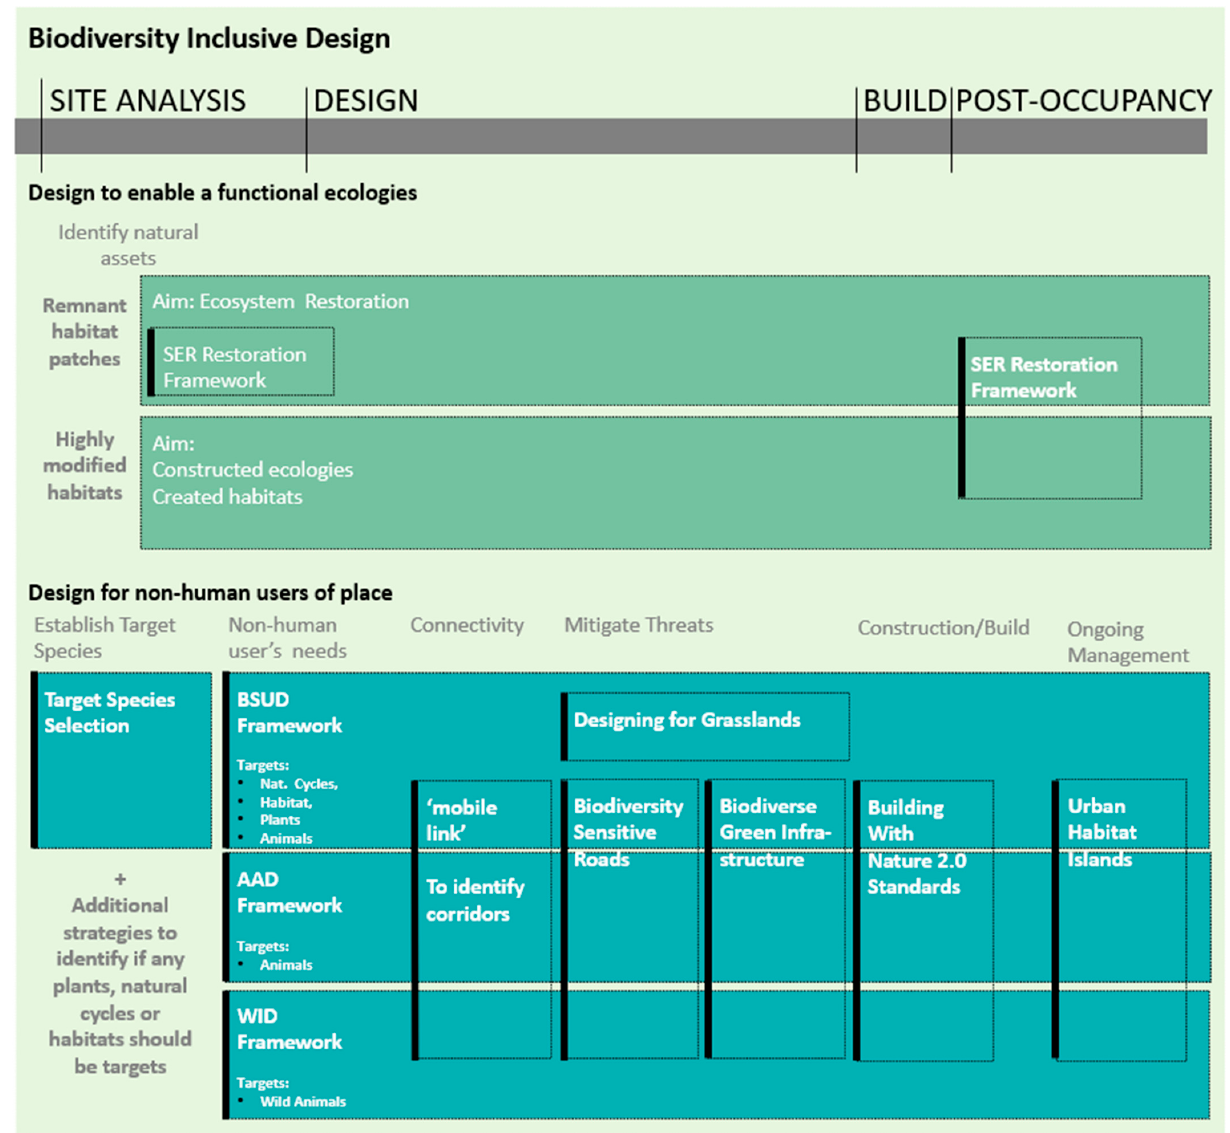
Figure 6. A multi-framework nested approach to enabling non-human perspectives within the design process. The grey box at the top presents four out of the five stages of the design process. The light grey text highlights key activities for the design team to complete. The boxes with a thick black line on the left represent different design frameworks; their location indicates the dimension of action (design to enable functional ecologies or design for non-human users of place) and the activities that they are associated with. A single design process could use multiple frameworks